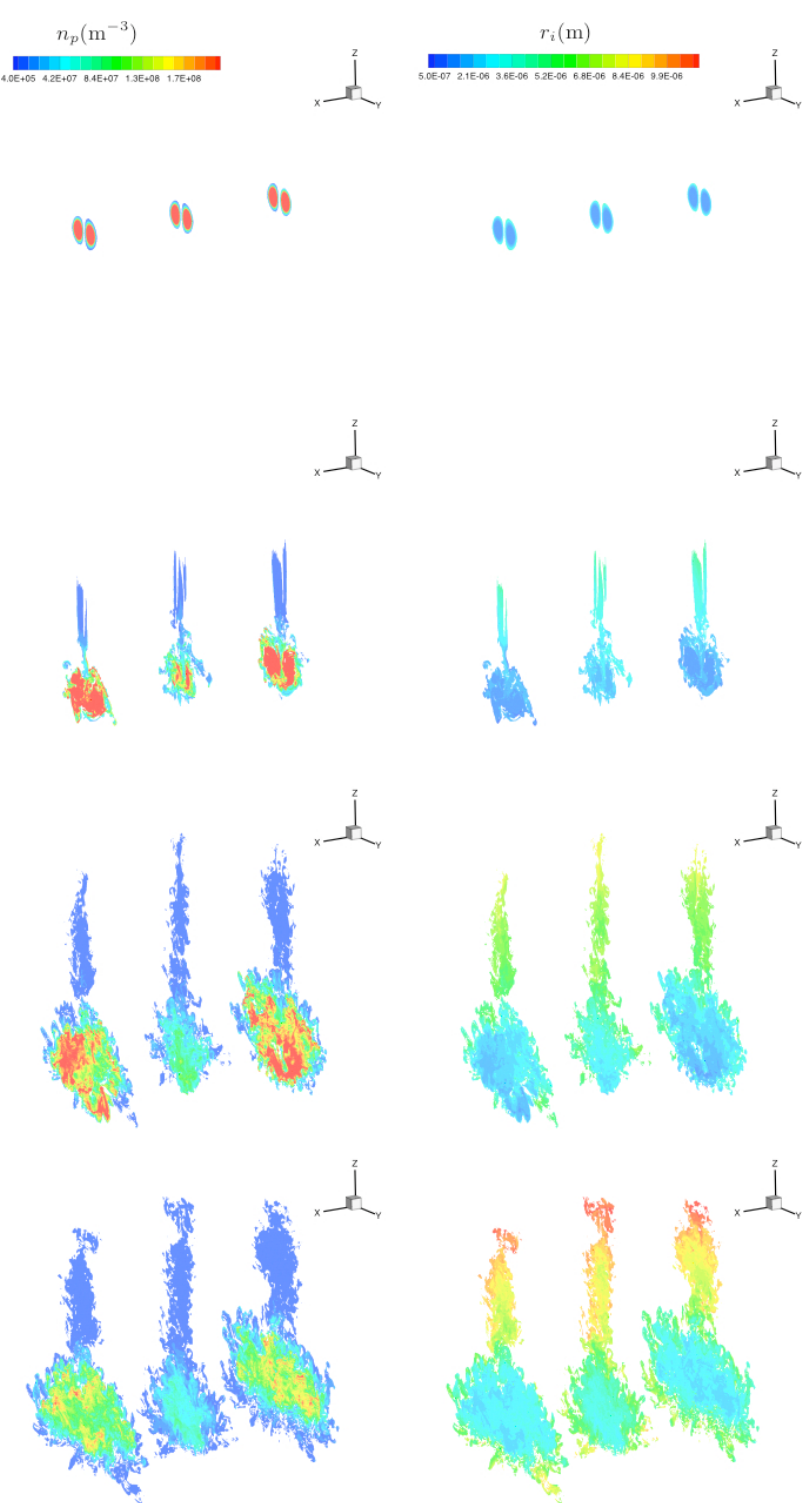
Fig. 8. Plane-cuts of particle number density (m − 3 , left panels) and ice crystal radius (m, right panels) at x = 0 and 400m (vortex ring locations), and x = 160m (vortex break-up location) during the vortex and early dissipation regimes (run VD1). From top to bottom: t = 80s, 160s, 240s, and